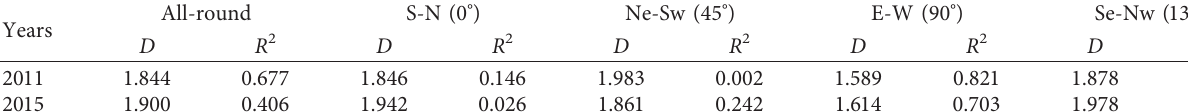
Table 4: Variation dimension of green utilization efficiency pattern of urban construction land.